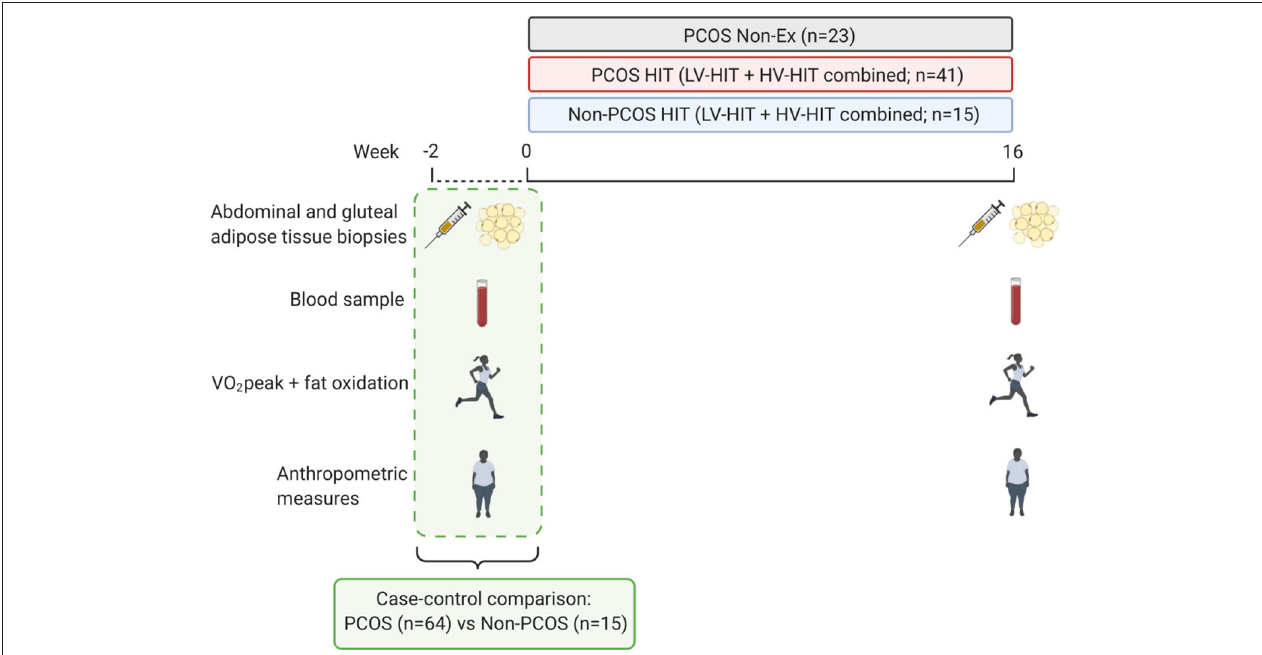
FIGURE 1 | Study protocol. The testing days included: abdominal and gluteal subcutaneous adipose tissue biopsies, fasting blood sampling, VO 2 peak, submaximal exercise test to measure fat oxidation rates, body composition measures, and waist and hip circumference. The adipose tissue was used to measure mitochondrial respiration and cell size. The testing days were repeated after a 16 weeks intervention period of either performing high-intensity interval training or no exercise. PCOS, Polycystic ovary syndrome; Non-Ex, no exercise; HIT, high-intensity interval training; LV-HIT, low-volume high-intensity interval training; HV-HIT, high-volume high-intensity interval training; VO 2 peak, peak oxygen uptake. Created with